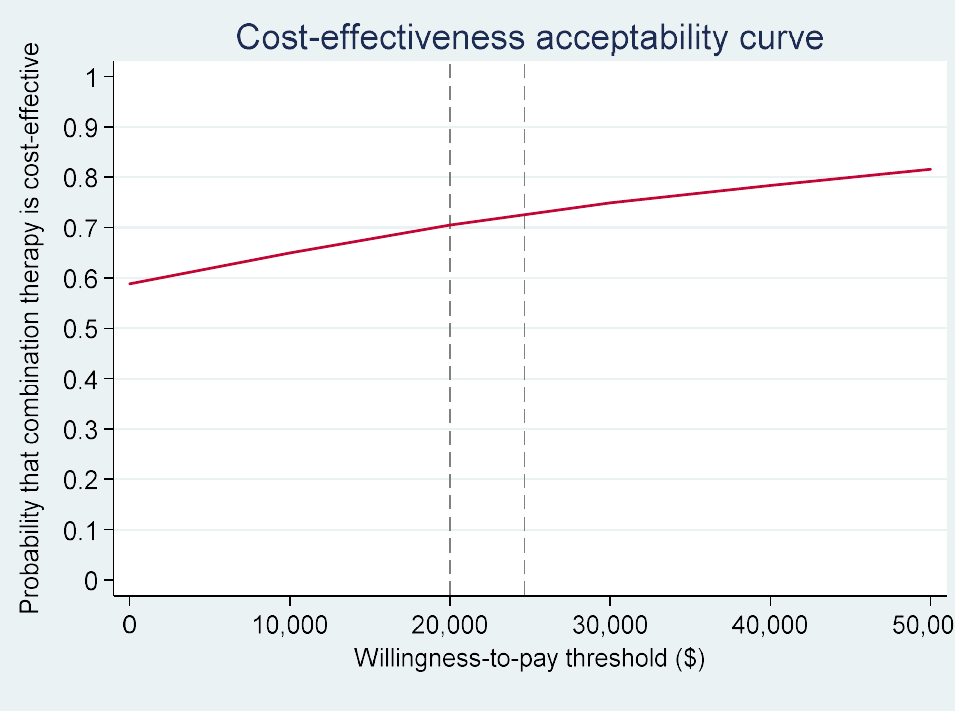
Figure 4. Cost–Effectiveness Acceptability Curve (societal perspective).